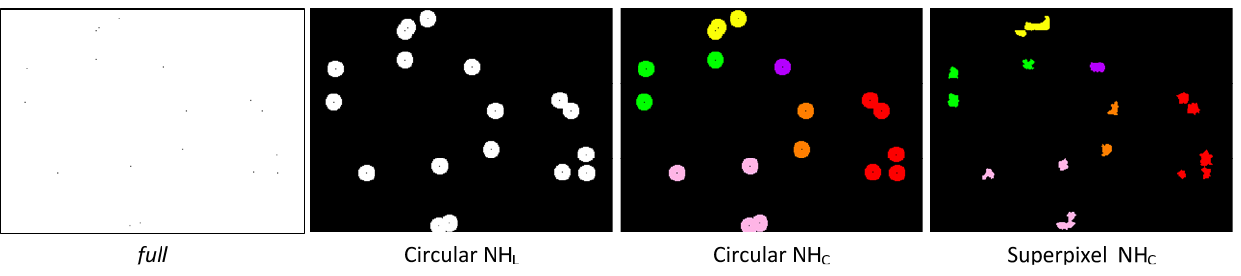
indicate the class label. C